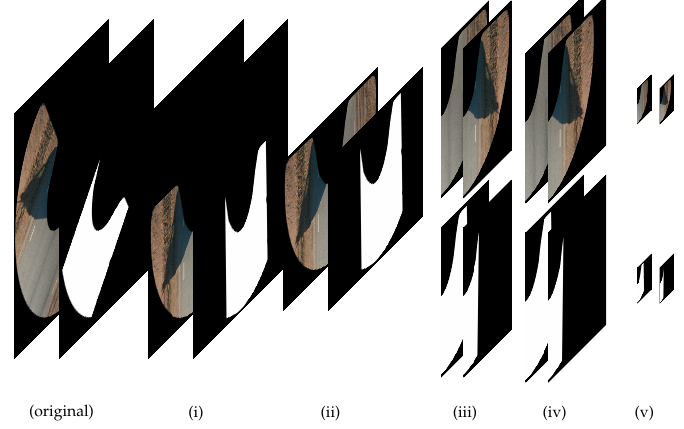
Figure 5. Road area image